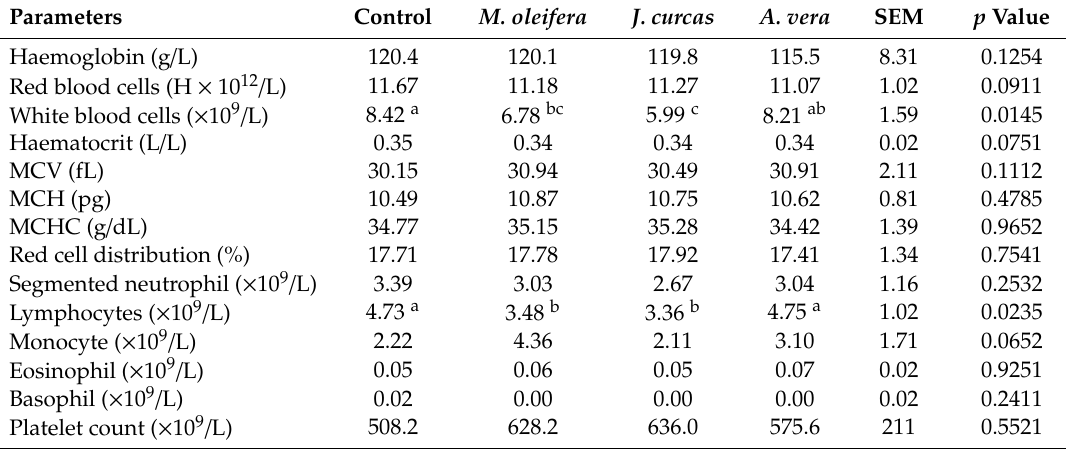
Table 2. Haematological parameters of SA Mutton Merino lambs drenched for 75 days with extracts of Moringa oleifera , Jatropha curcas and Aloe